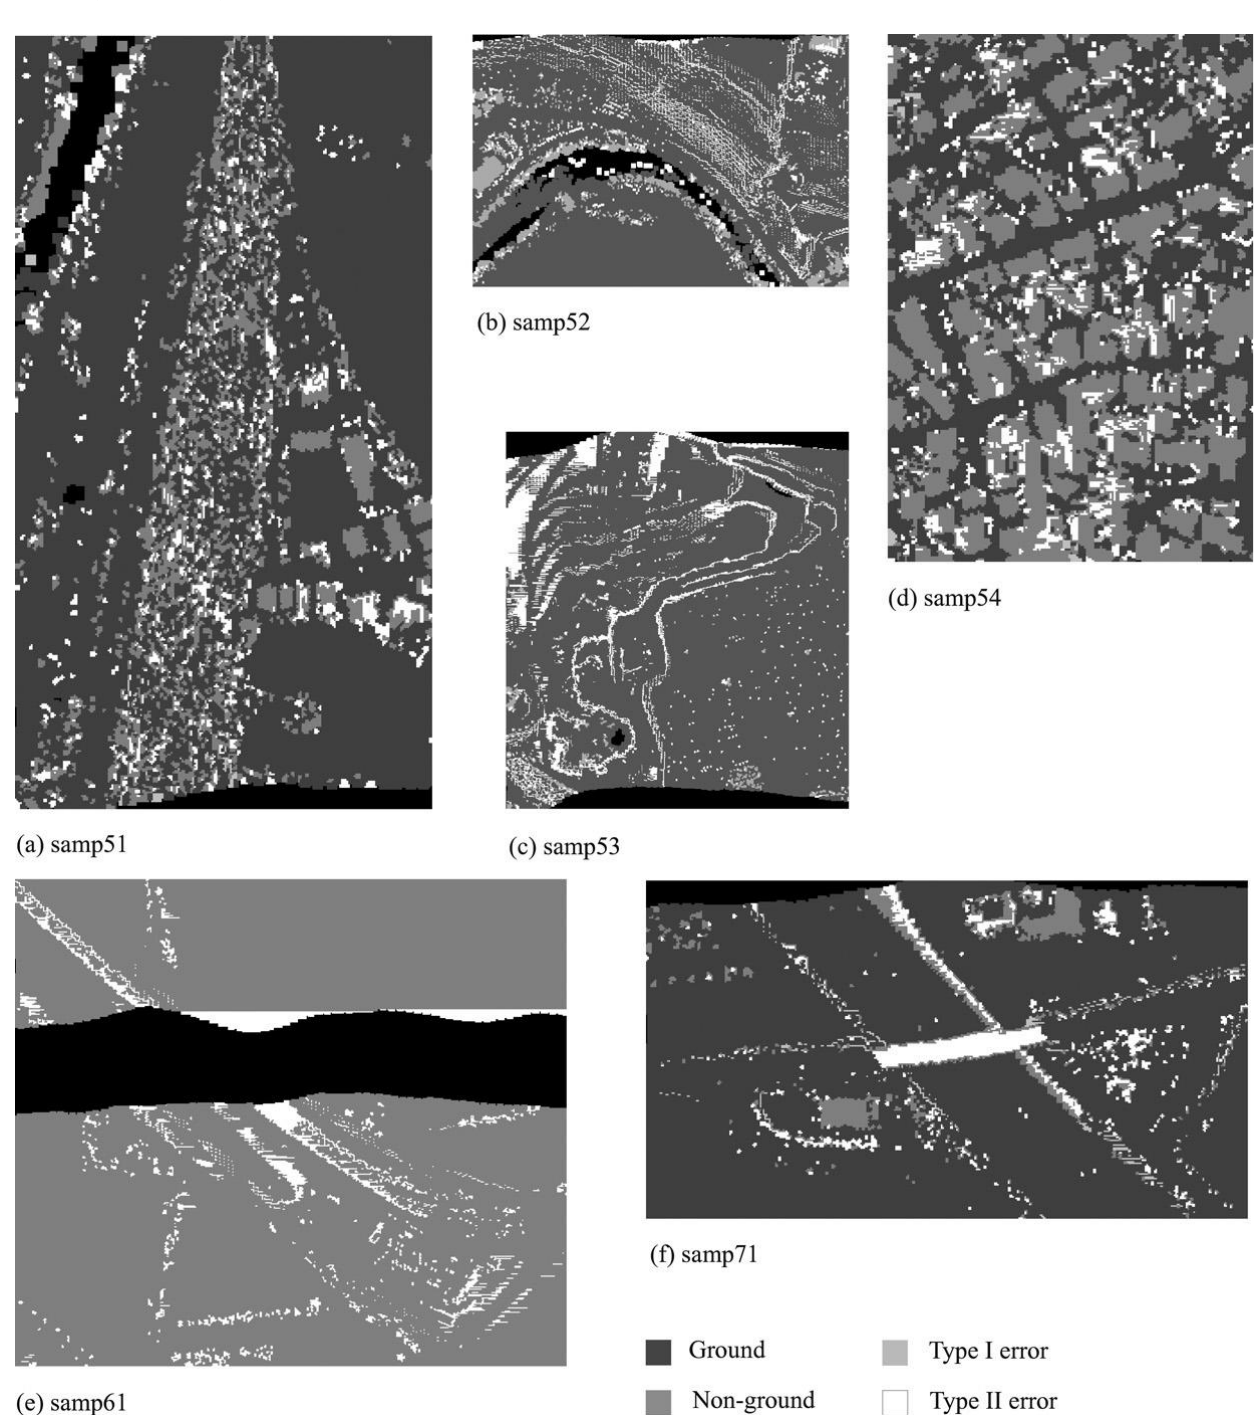
Figure 2. Error distribution for forest sites 5-7. Each image is displayed at a unique scale (source